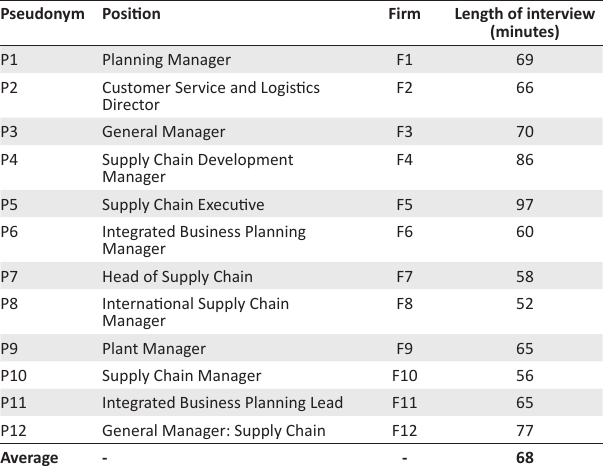
TABLE 4: Participants’ profiles.